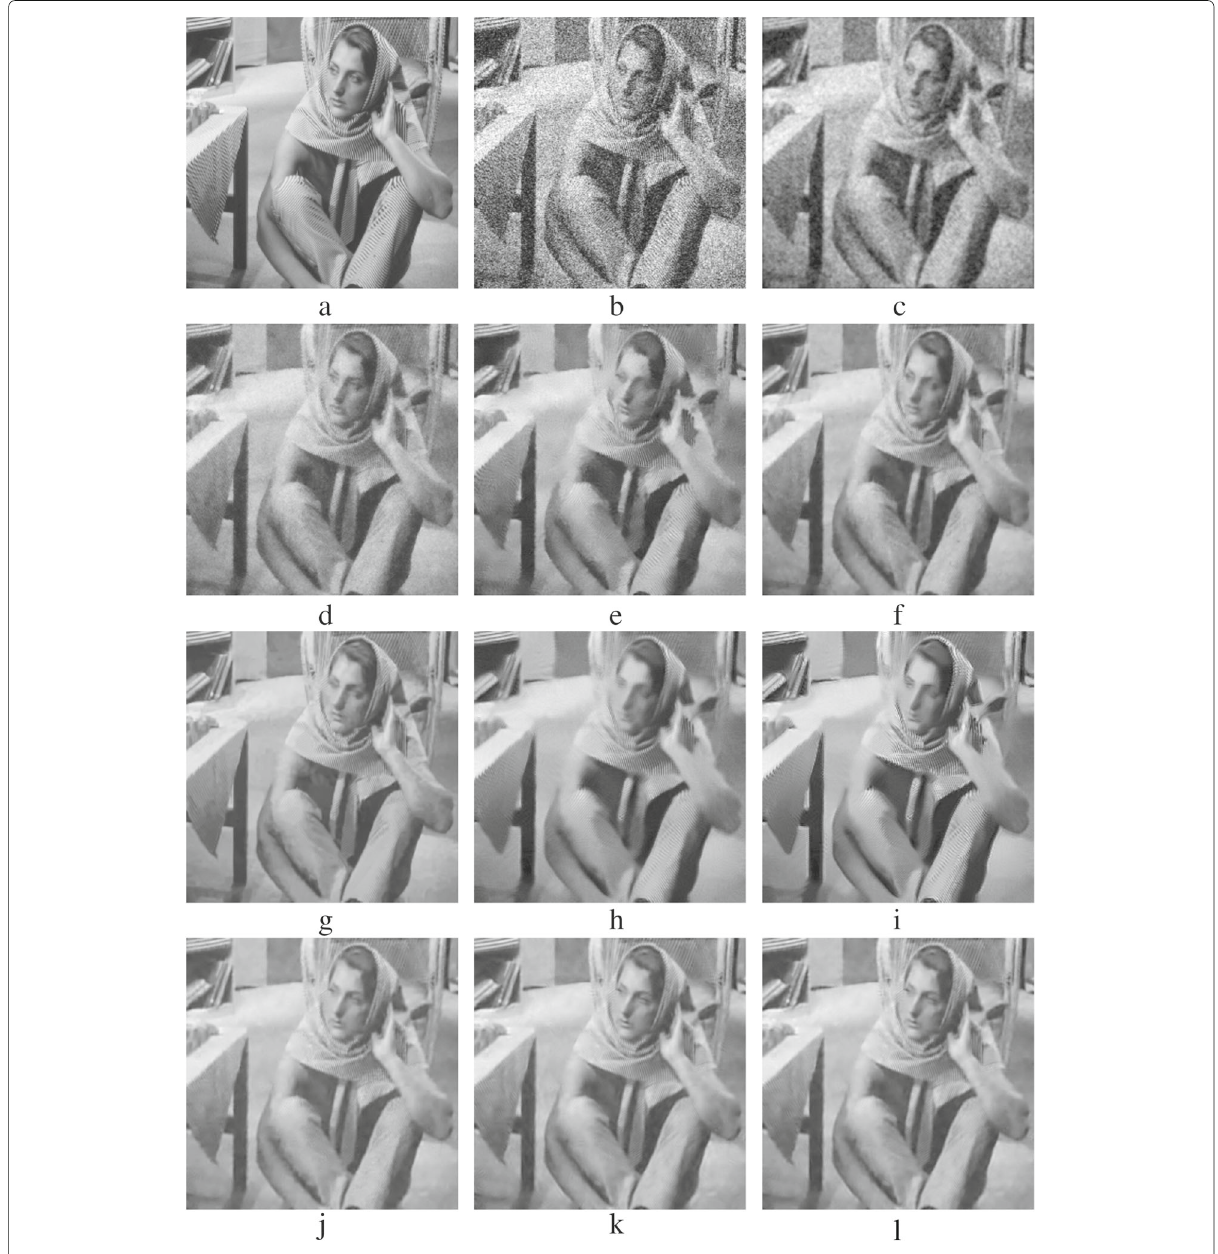
Fig. 15 Denoised Barbara images: a Original Barbara image; b AWG noise, σ = 40; c AD ; d bilateral filtering, e NL-Means filtering, f K-SVD, g BM3D, h non-itPPB, i it-PPB, j PGPCA, k PLPCA, and l